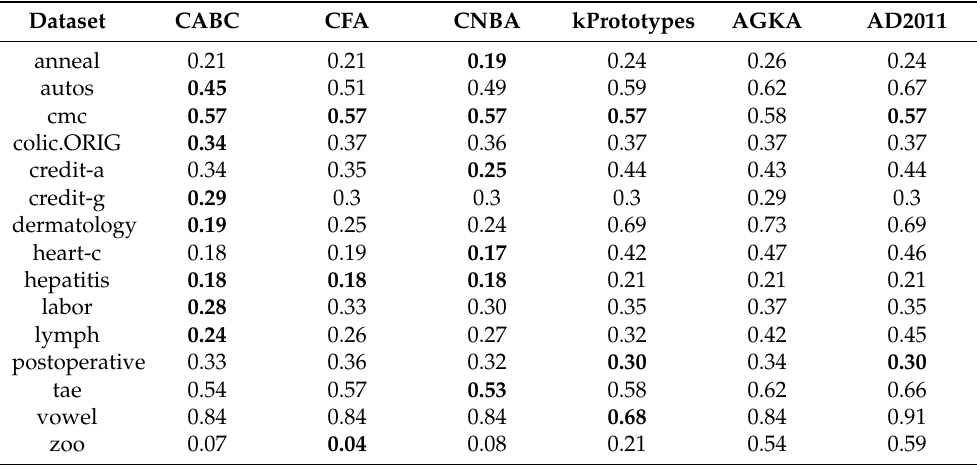
Table 7. Performance results according to cluster error of CABC, CFA and CNBA with respect to other algorithms.